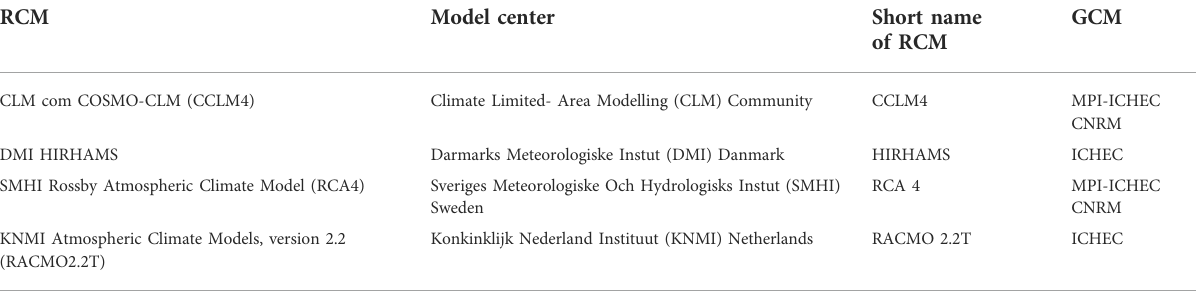
TABLE 3 Characteristics of the CORDEX-Africa models used (Luhunga et al., 2018).